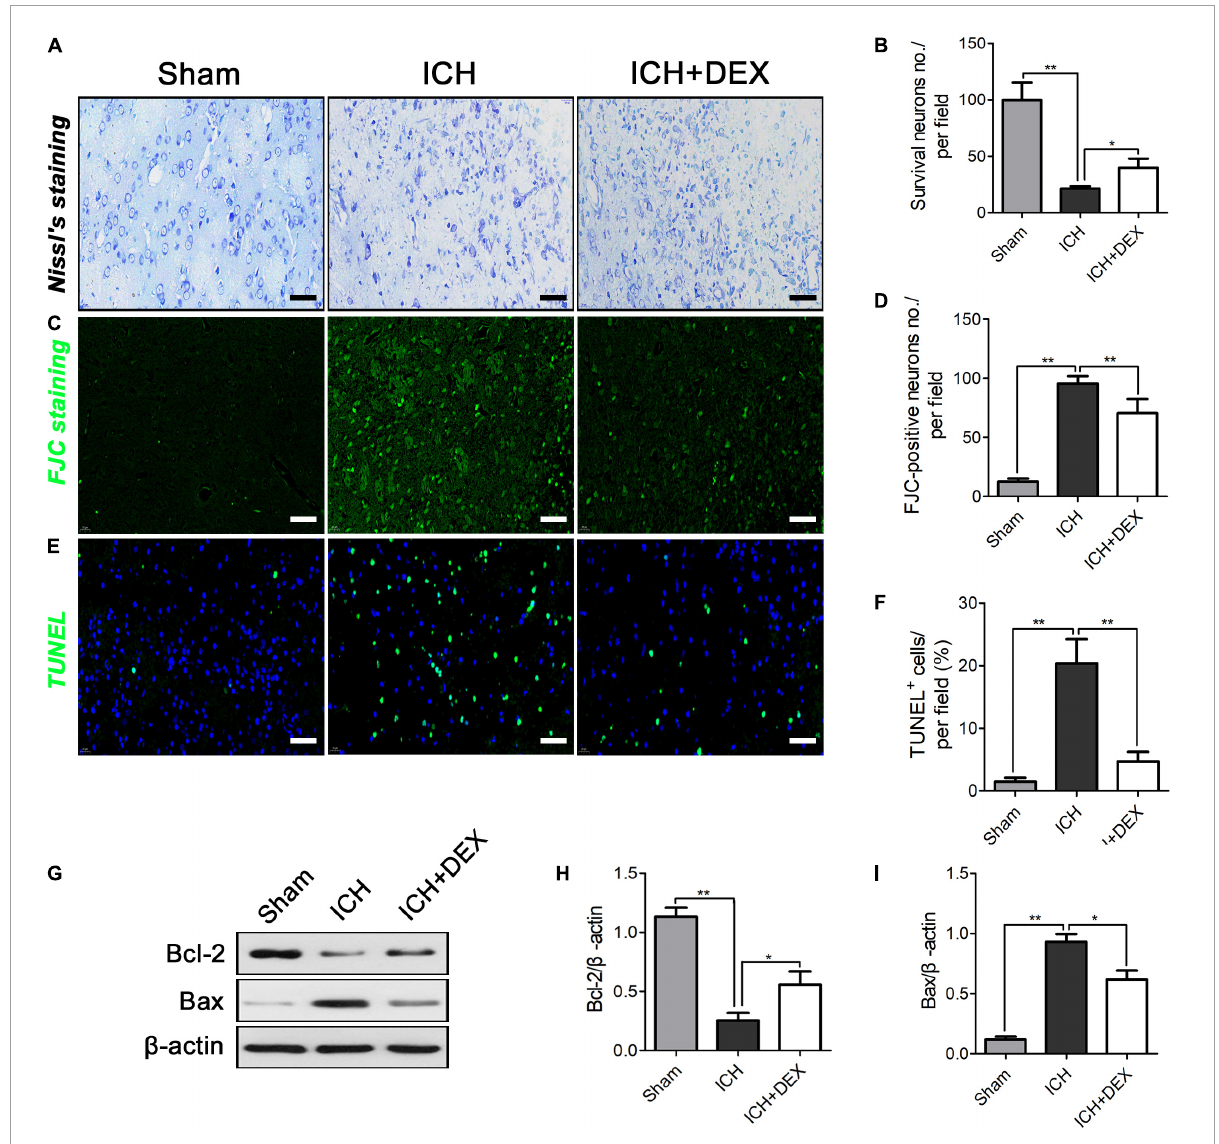
FIGURE2 (A,B) Compared with the Sham group, the number of surviving neurons were significantly reduced after ICH. However, after being administered with DEX, more surviving neurons were observed three days post-ICH. On the 3rd day post-ICH, (C,D) a significantly increased number of FJC-positive cells was observed in the ICH group compared with the Sham group. However, DEX treatment markedly reduced the number of FJC-positive cells. (E,F) ICH could induce obvious neuronal cell loss and apoptosis in the rat brain. DEX could dramatically decrease the ratio